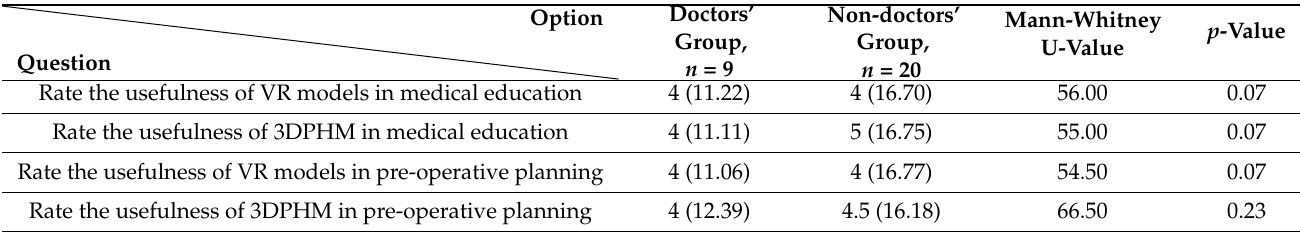
Table 6. Subgroup analysis for participants’ responses on the ratings for VR and 3DPHM a